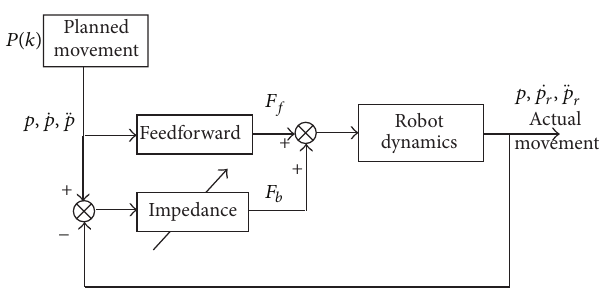
Figure 9: Scheme of HRC control model. The feedforward 𝐹 𝑓 corresponds to the force of human and 𝐹 𝑏 is force feedback based on PD impedance controller which is employed to regulate robot joint or endpoint